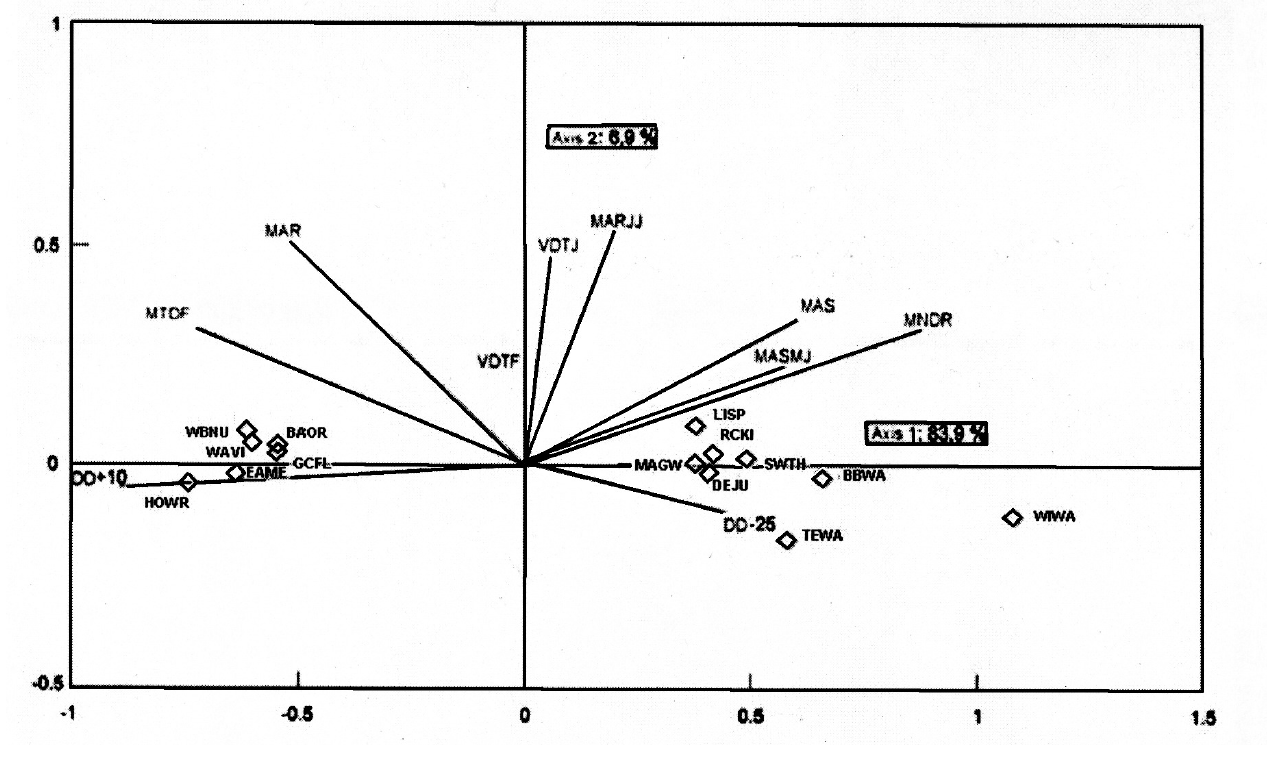
Fig. 3. Distribution of 14 potential bird indicator species along the first 2 axes of a Canonical Correspondence Analysis (CCA) with climatic variables. See Table 3 for climatic code definitions. Bird species are: (HOWR) House Wren, (AEME) Eastern Meadowlark, (WBNU) White-breasted Nuthatch, (WAVI) Warbling Vireo, (BAOR) Baltimore Oriole, (GCFL) Great Crested Flycatcher, (LISP) Lincoln Sparrow, (MAGW) Magnolia Warbler, (DEJU) Dark-eyed Junco, (RCKI) Ruby-crowned Kinglet, (SWTH) Swainson’s Trush, (TEWA) Tennessee Warbler, (BBWA) Bay-breasted Warbler, and (WIWA) Wilson’s Warbler. This group of 14 consists of species for which 16% or more of the variation is explained by climate, correcting for the effect of land